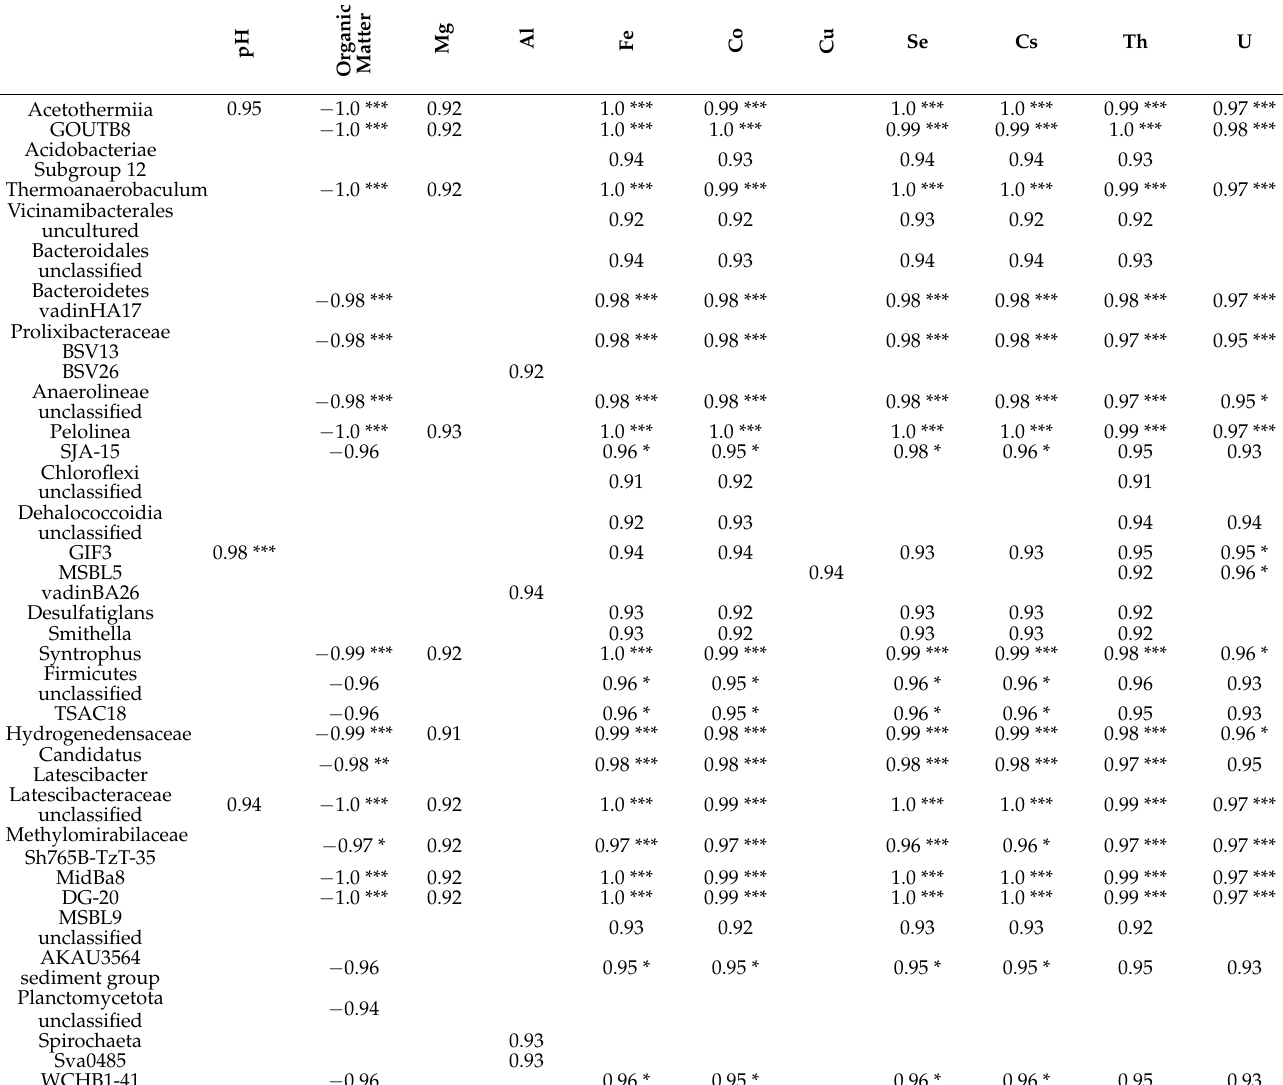
Table A2. Pearson correlation coefficients of the Bonferroni-corrected correlations between relative abundance of bacterial genera and physicochemical parameters and metal concentrations. Correlation coefficients for pairs with p < 0.05 are